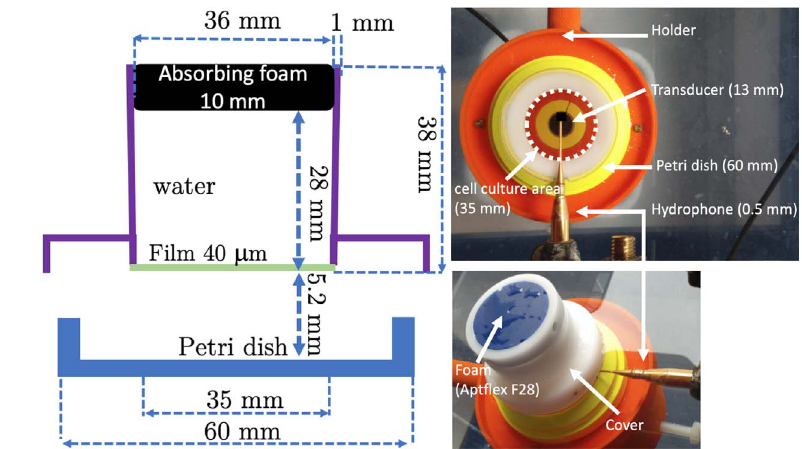
Figure 1. Schematic drawing and pictures of the Petri dish/anti-re fl ection cover